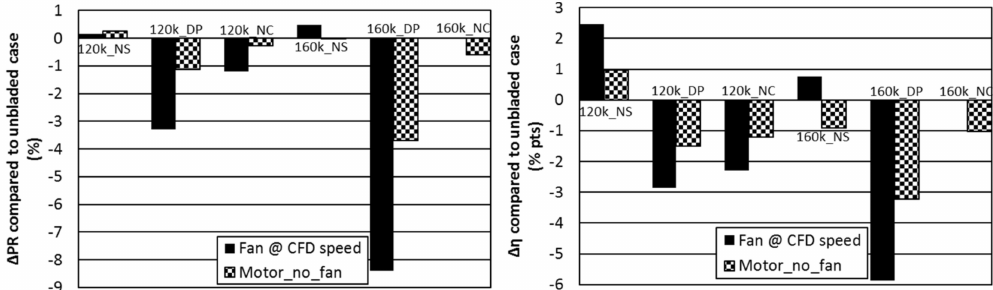
Figure 17. Illustration of stage performance for the axial fan and “Motor_no_fan” configurations in comparison to the “Unbladed” case.